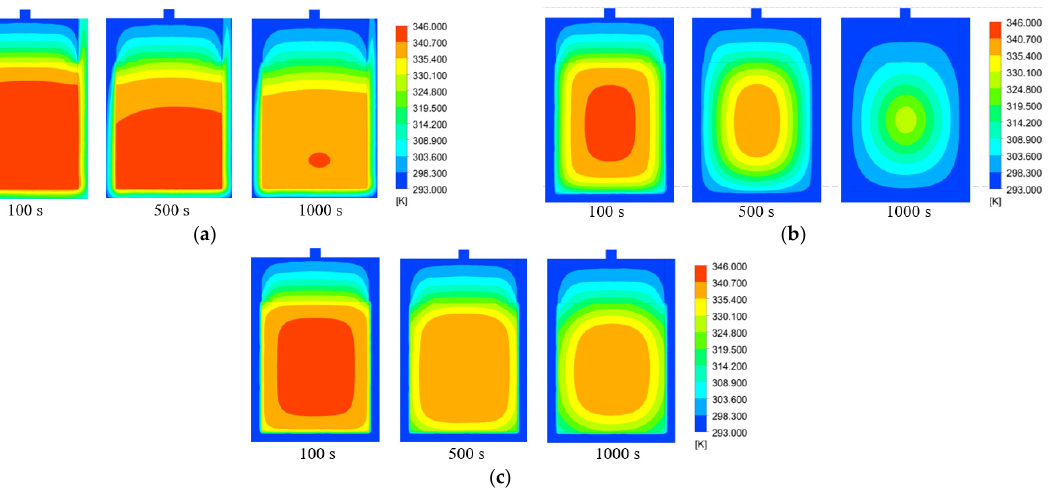
Figure 11. A temperature distribution cloud chart at different times of the reaction tank subjected to different cooling media of air, water, and oil. ( a ) Air as the cooling medium; ( b ) Water as the cooling medium; ( c ) Oil as the cooling medium.